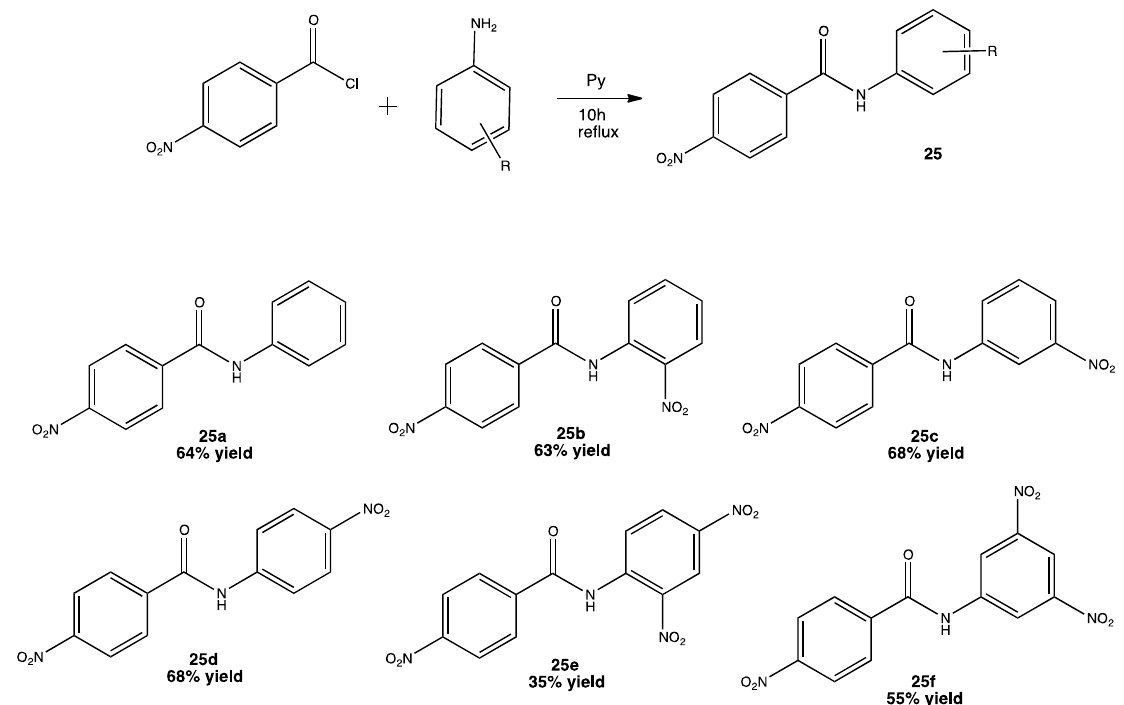
Figure 11. Compound 25f showed a potent inhibition of pro-inflammatory cytokines making it a good candidate as a lead compound for further research